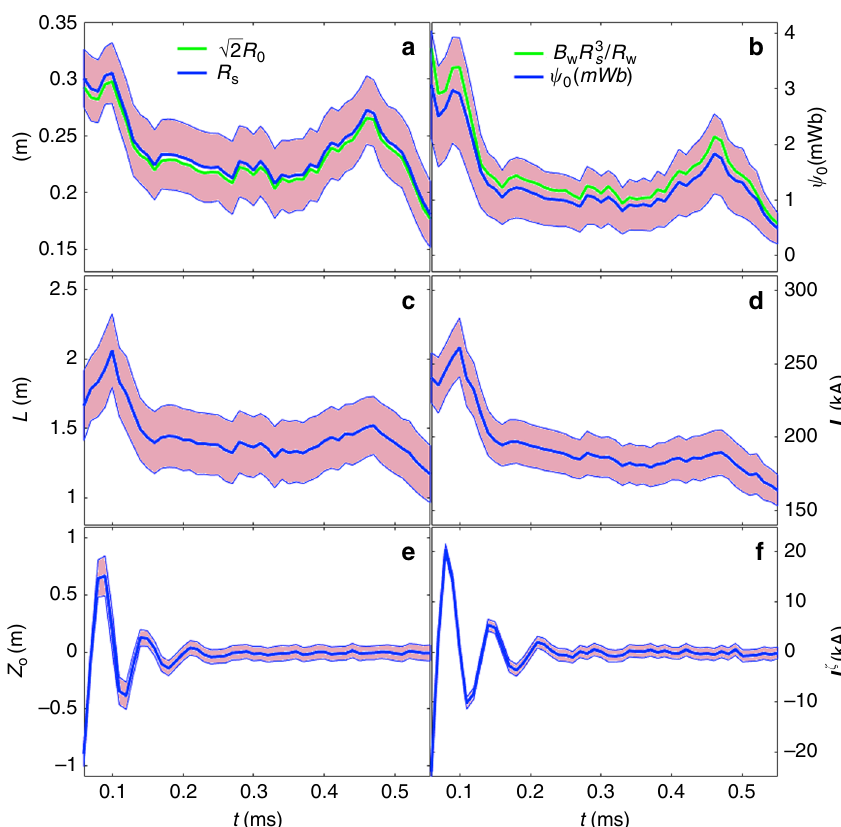
Fig. 4 Inference of Alfvenic oscillations. Inferred plasma variables at the start of the C-2U shot #49040. Solid lines correspond with the expected values of the posterior distribution, and shaded areas are a measure of the uncertainty of the inferred variables corresponding to one standard deviation. a Separatrix radius R s (blue) and o-point radius R 0 times (blue) and the trapped fl ux approximation for a long FRC (green). c Separatrix length (distance between x-points). d Total plasma current. e o-point